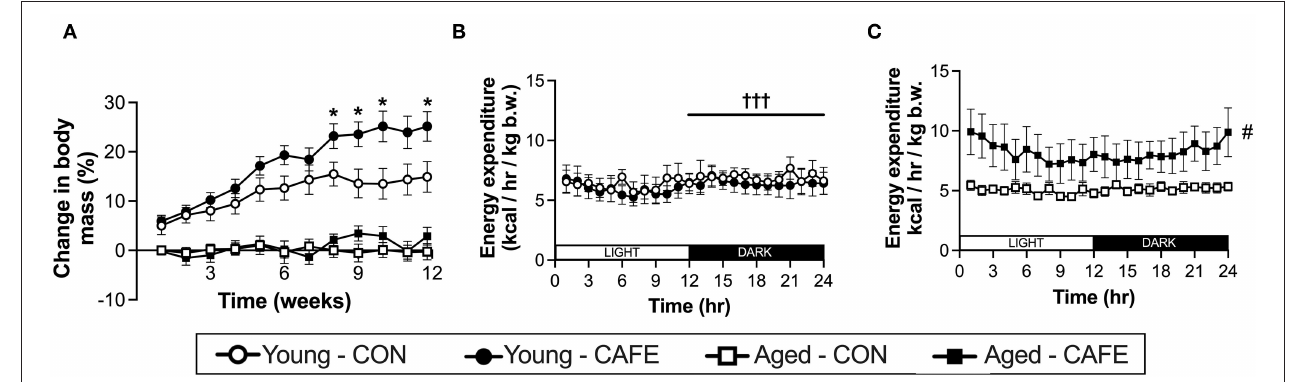
FIGURE 2 | Impact of an experimental cafeteria diet on body weight and energy expenditure in young and old Brown Norway rats. Changes in body mass reported relative to baseline in young and old animals across the 12-week intervention (A) . Energy expenditure examined by indirect calorimetry after 8 weeks of the dietary intervention, expressed per kg of body weight (B,C) . * P < 0.05: significantly different from time and age-matched control. # P < 0.05: significant main effect of dietary intervention. ††† P < 0.001: significantly different from light phase. Values represent means ± SEM. n = 4–8/group.